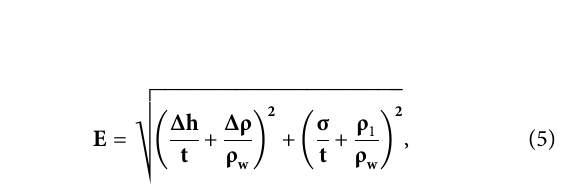
FIGURE 6 | Glacier area changes for 2000 – 2020 in the Altai Mountains. (A) Glacier area change. (B) Glacier area change rate. The glacier area in the map represents the glacier area in 2000; we set a threshold (glacier areas in grid > 1 km 2 ) to establish the grid.